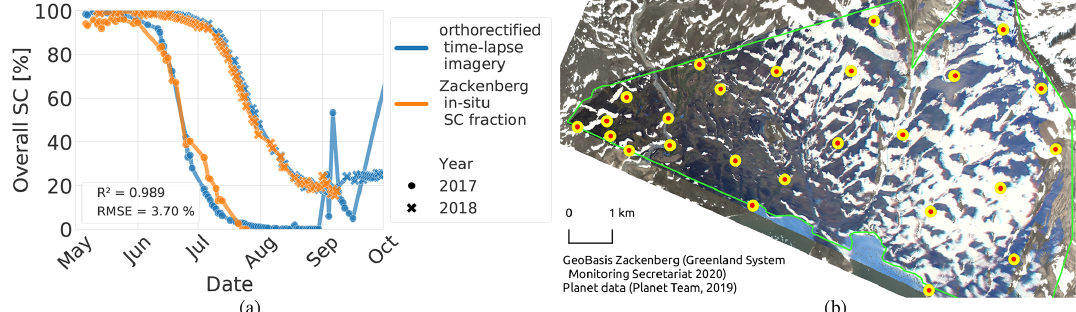
Figure 6. (a) Seasonal development of snow cover (SC) deducted from the orthorectified time-lapse imagery compared with Zackenberg in situ snow cover fraction data. Their level of correlation is represented by R 2 and RMSE. (b) Orthorectified master image and PlanetScope scene in the background with their respective ground control points (GCPs). The center of the yellow dot indicates the projected location of the GCP, while the red dot shows the true location of the GCP. The distance between both is the orthorectification error (RMSE = 9.4m).